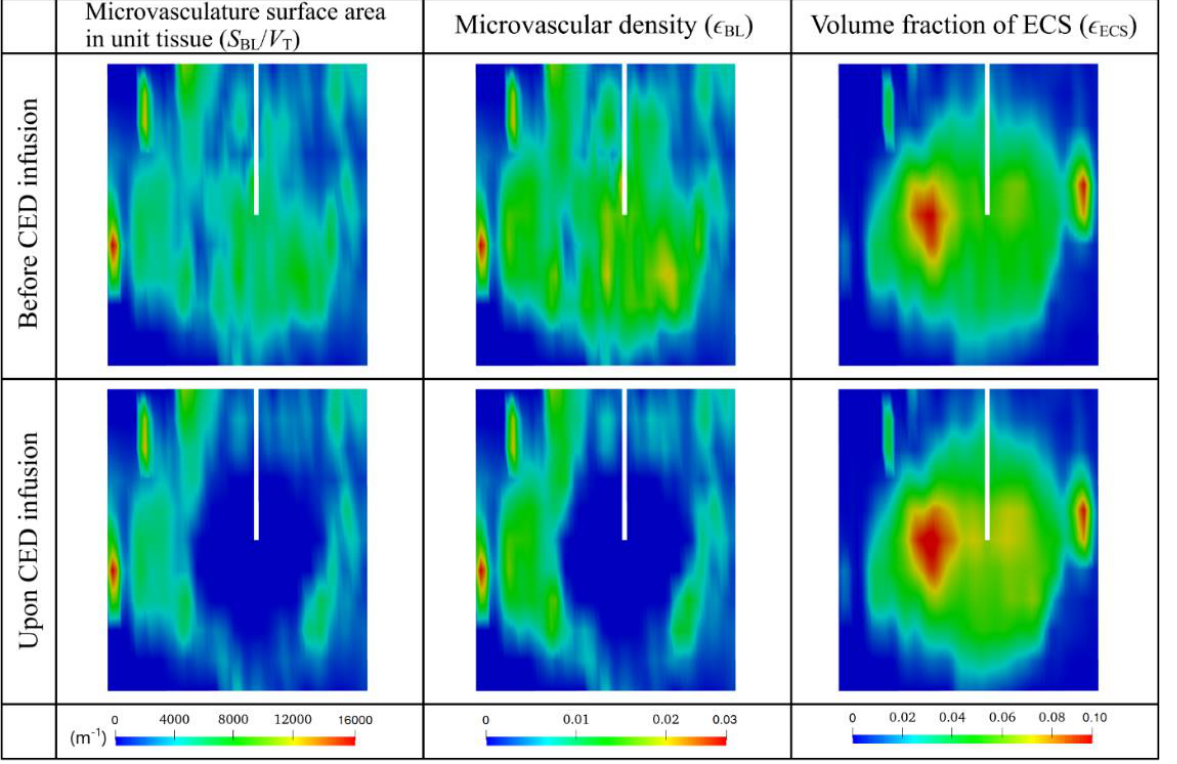
Figure A2. Distribution of tissue biological properties before and after the combination therapy. Results in the upper and lower panels are taken at time zero and Day 3, respectively.